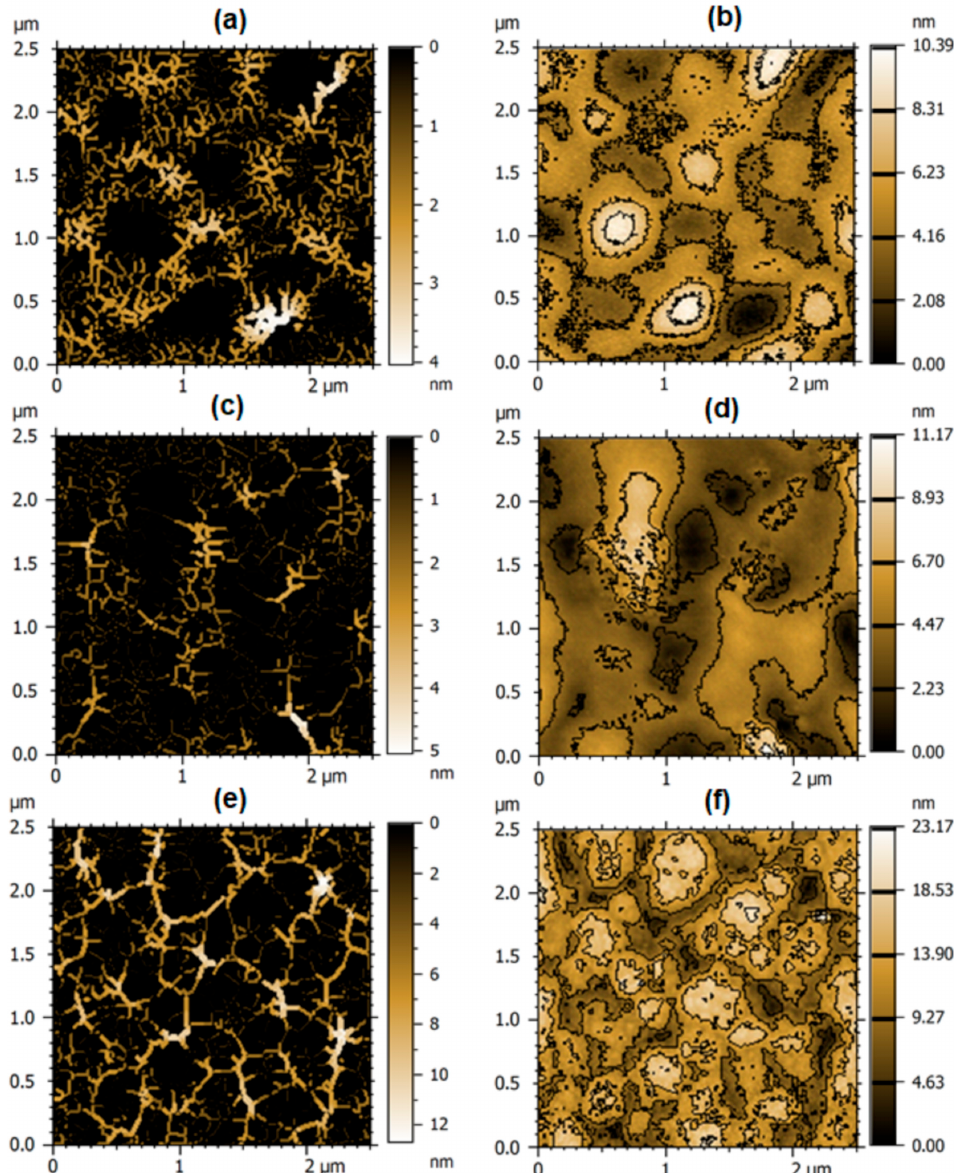
Figure 3. Qualitative rendering of furrows and contour lines systems of the surface microtexture of ( a , b ) GdMnO650, ( c , d ) GdMnO750, and ( e , f ) GdMnO850. ( a , b ) GdMnO650, ( c , d ) GdMnO750, and ( e , f )